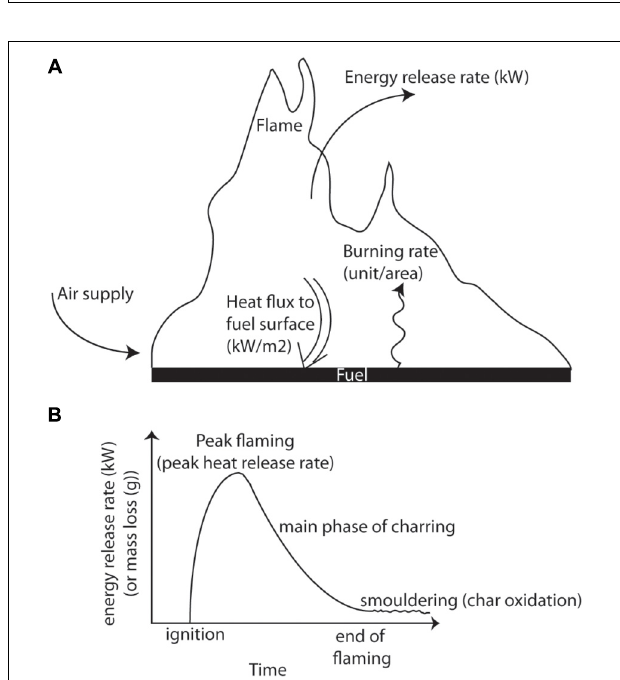
FIGURE 10 | (A) Schematic of the directions of energy release and energy fluxes associated with flaming combustion of a solid fuel. (B) Schematic heat release rate profile highlighting key transitions during